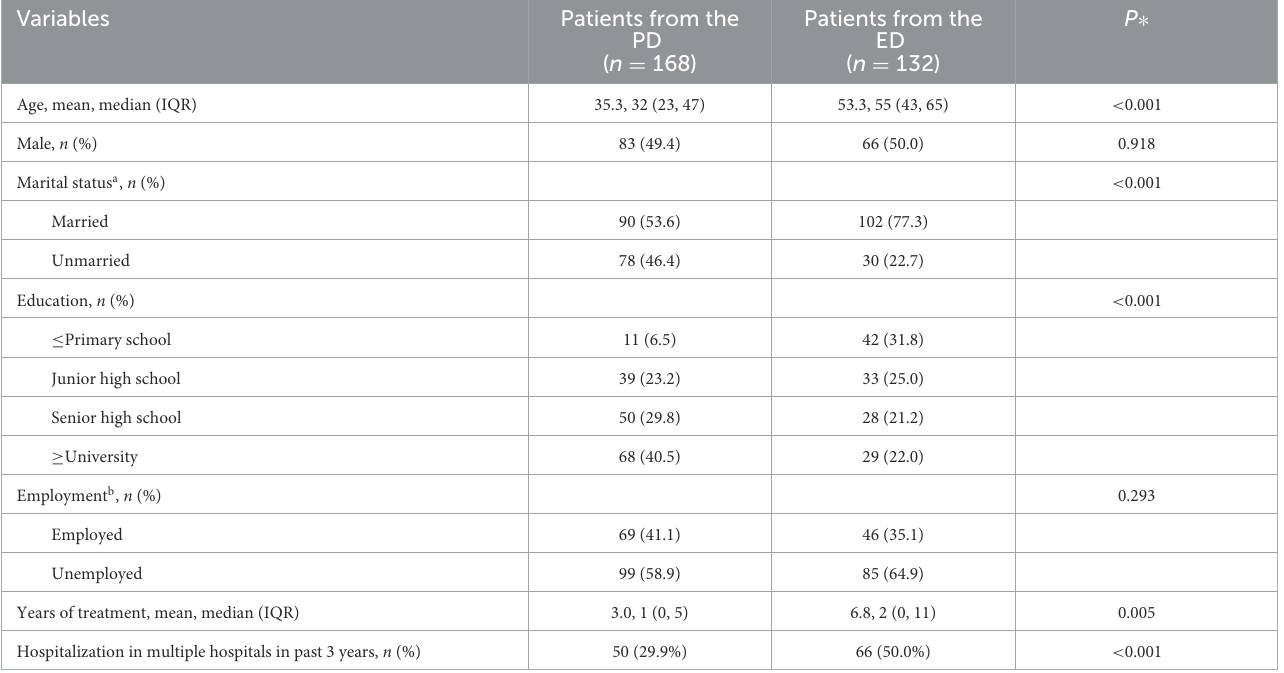
TABLE 1 Participant